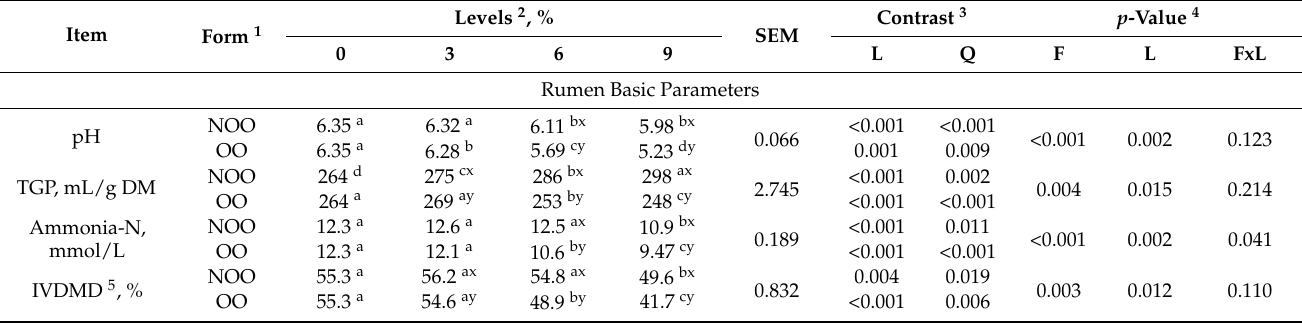
Figure 3. Size distribution (nm) and apparent Zeta potential (mV) of oil-in-water nanoemulsified samples of three different nanoemulsions: ( a ) olive oil-in-water nanoemulsion, ( b ) corn oil-in-water nanoemulsion, and ( c ) linseed oil-in-water nanoemulsion. Table 4. Effect of the supplementation of raw and nanoemulsified olive oil on basic rumen parameters, volatile fatty acid, and fatty acid